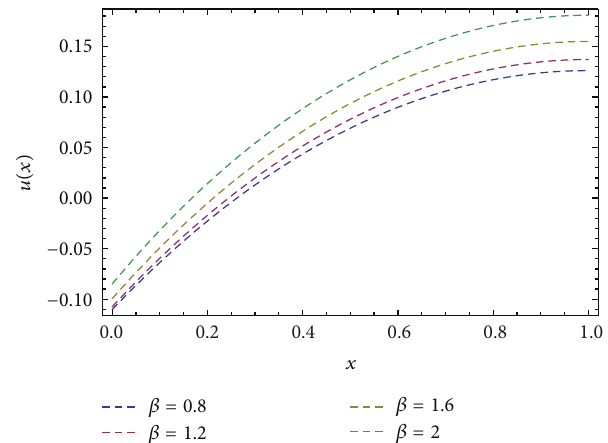
Figure 10: The influence of the non-Newtonian effect “ 𝛽 ” on the velocity profile 𝑢(𝑥) of drainage problem keeping 𝑚 = 0.5 , 𝑀 = 1 , and Λ = 0.2 .